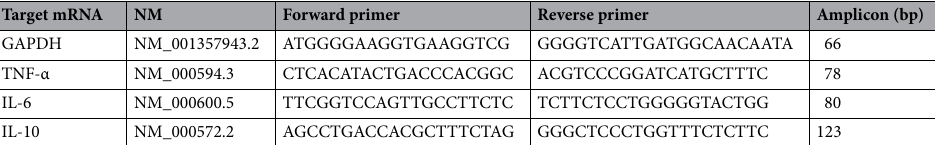
Table 5. Primers for RT-qPCR. Primers for each gene of interest were designed for each target mRNA (TNF- α, IL-6, IL-10) and the internal standard